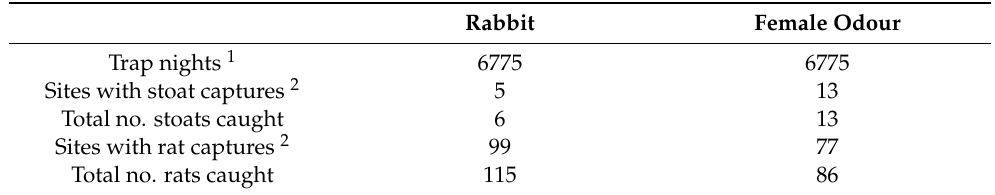
Table 3. Captures of stoats and rats on dried rabbit meat or female stoat bedding lure during the field trials at Abel Tasman, April–August